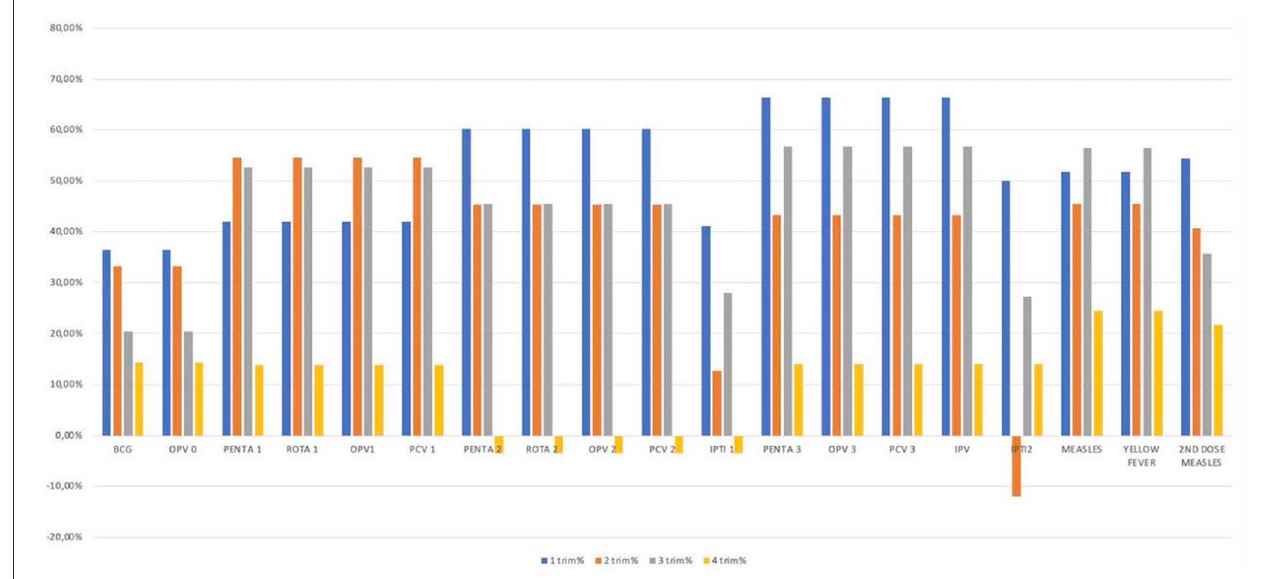
FIGURE 2 | Differences in the number of vaccinations performed per trimester in the 2 years. The figure shows the analysis per trimester; the 2 years studied have been divided in eight trimesters, four per year. The graph shows on the abscissa line the different vaccines studied and on the line of the ordinates the differences in percentage between the vaccines performed in the first and in the second year. Different vaccines showed different deflections with the first and the second trimester most affected for most vaccinations.